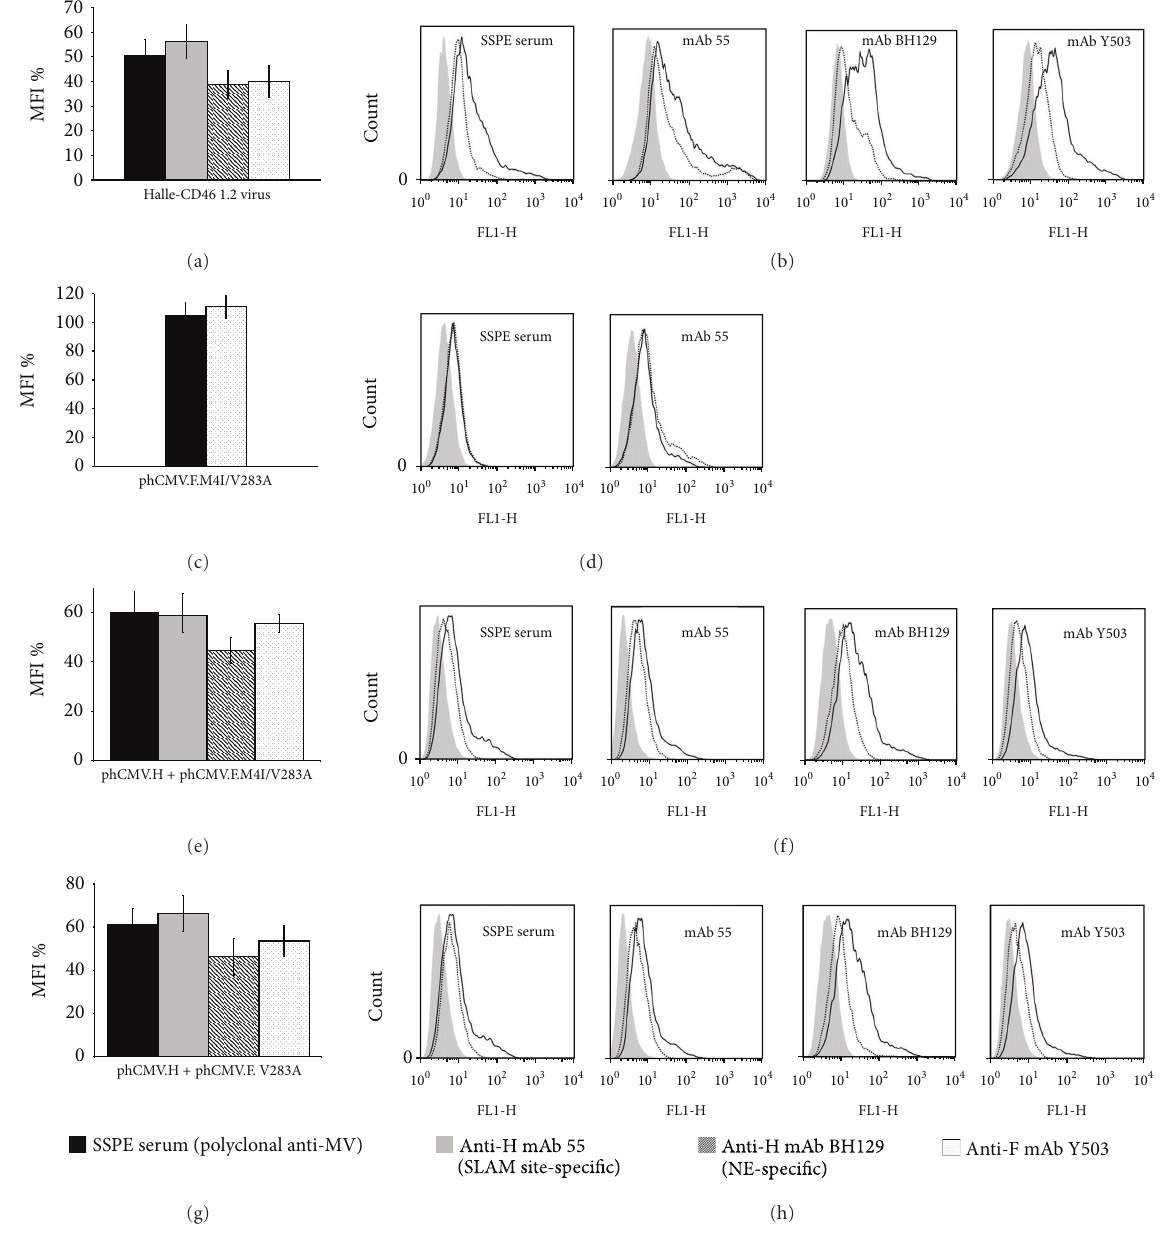
Figure 5: Flow cytometry analysis of escape mutant Halle-CD46 1.2 (H: no change; F: M4I, V283A; M: No change). Vero-SLAM cells infected with the escape mutant virus or transfected with phCMV plasmid expressing the mutated F protein, either alone or with a phCMV plasmid expressing the nonmutated H protein, in the presence of antifusion tri-peptide FIP, were analysed 1 day afterinfection (or after transfection) using the indicated antibodies. Each overlay histogram represents one experiment; the MFI histogram data represent the mean percentages ± standard deviations for three experiments. These values were obtained by using nonmutated Halle virus or expressed nonmutated Halle proteins as controls. (a) and (b)) Escape mutant Halle-CD46 1.2-infected cells; (c) and (d)) cells transfected with phCMV.F.M4I/V283A; ((e) and (f)) and ((g) and (h)) cells transfected with phCMV.H + phCMV.F.M4I/V283A or phCMV.F.V283A,